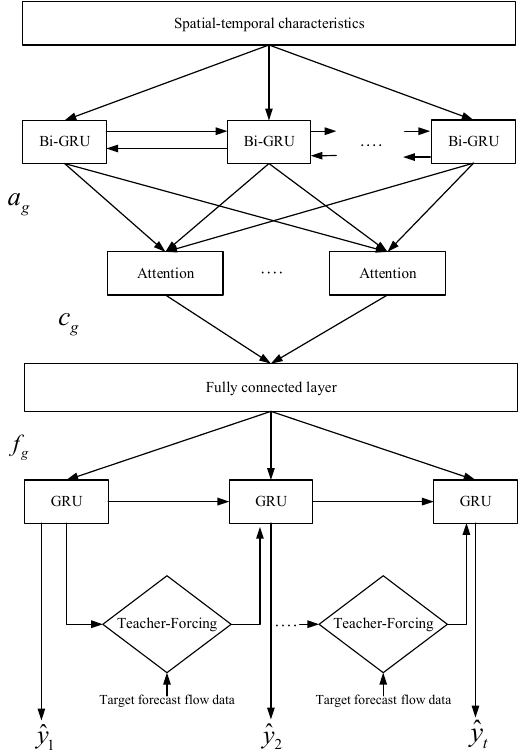
Figure 5. Decoder Figure 5. Decoder structure. Algorithm 1: Pseudo-Code for Training Procedure of MECG